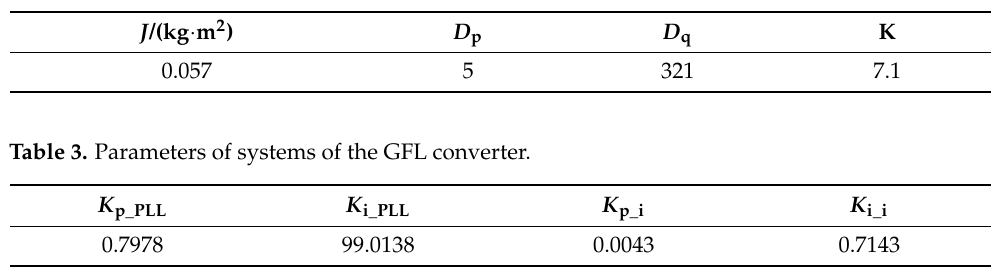
Table 2. Parameters of systems of the GFM converter.